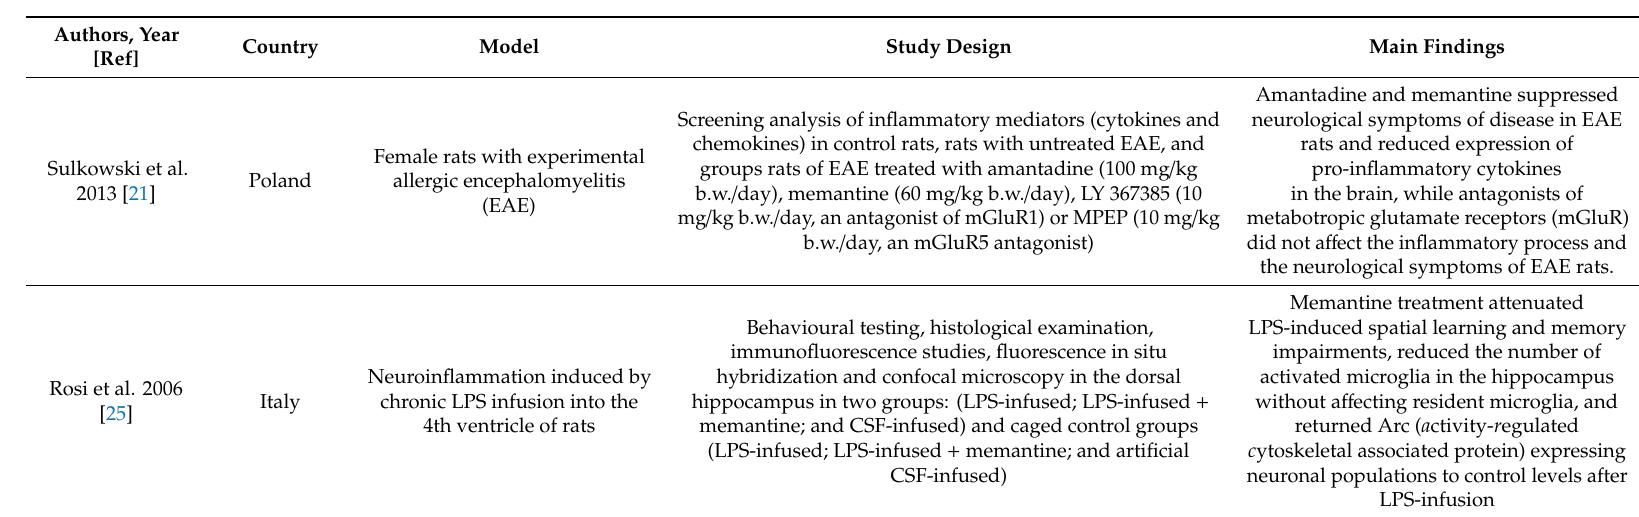
Table 2. Studies assessing the anti-inflammatory e ff ects of